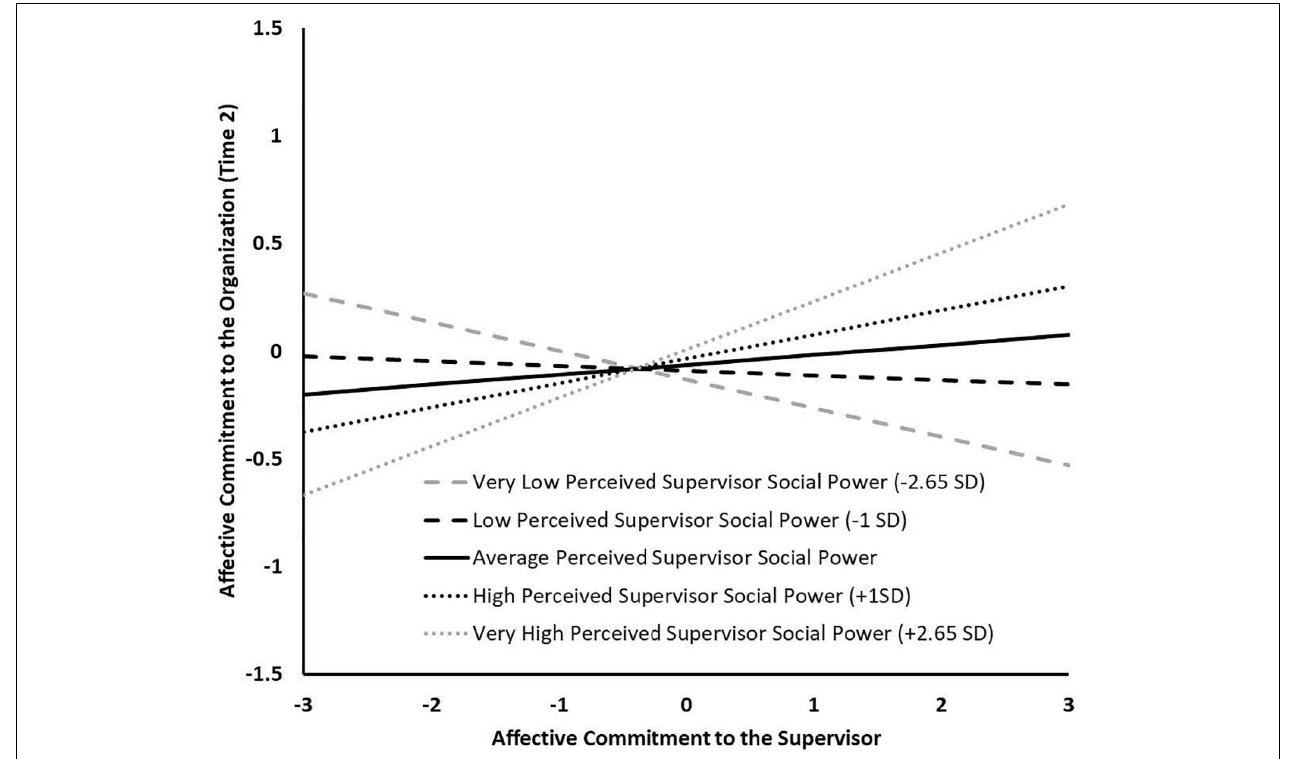
FIGURE 3 | Study 3 Simple Slopes for the Moderation Effect of Perceived Supervisor Social Power between Affective Commitment to the Supervisor and Organizational Commitment.